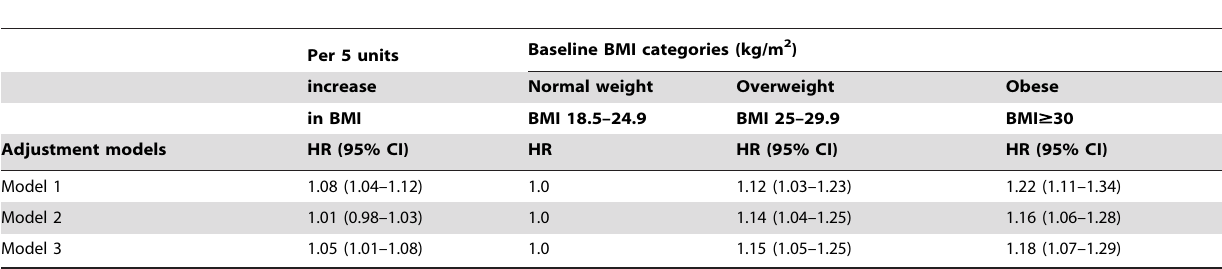
Table 4. Hazard ratios (HR) with 95% confidence intervals (CI) for all cancer in overweight and obese patients with type 2 diabetes, compared to patients with normal weight, using several models for adjustment with covariates.